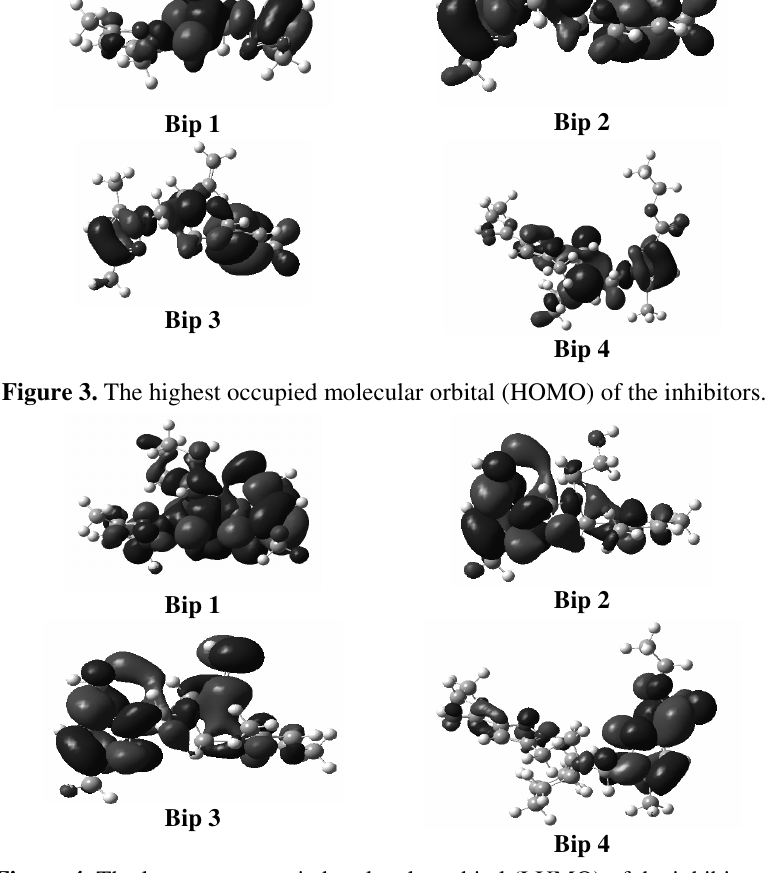
Figure 4. The lowest unoccupied molecular orbital (LUMO) of the